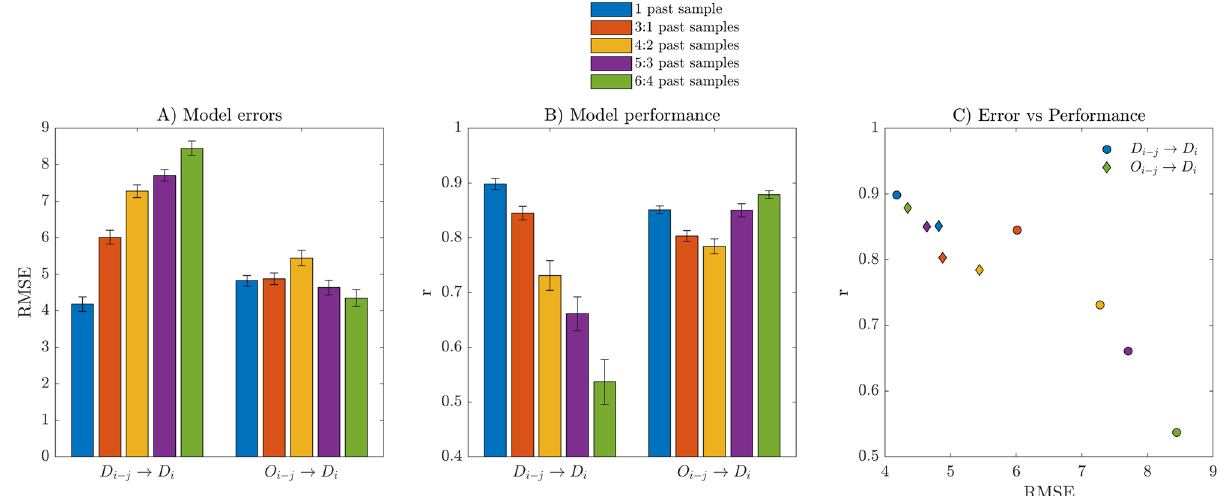
Figure 2. Evaluation of LSTM models performance for dengue forecasting based on aggregate time-series data. The models were trained and tested 30 times. Bars indicate mean values, and whiskers indicate a standard error, both for RMSE and r metrics.